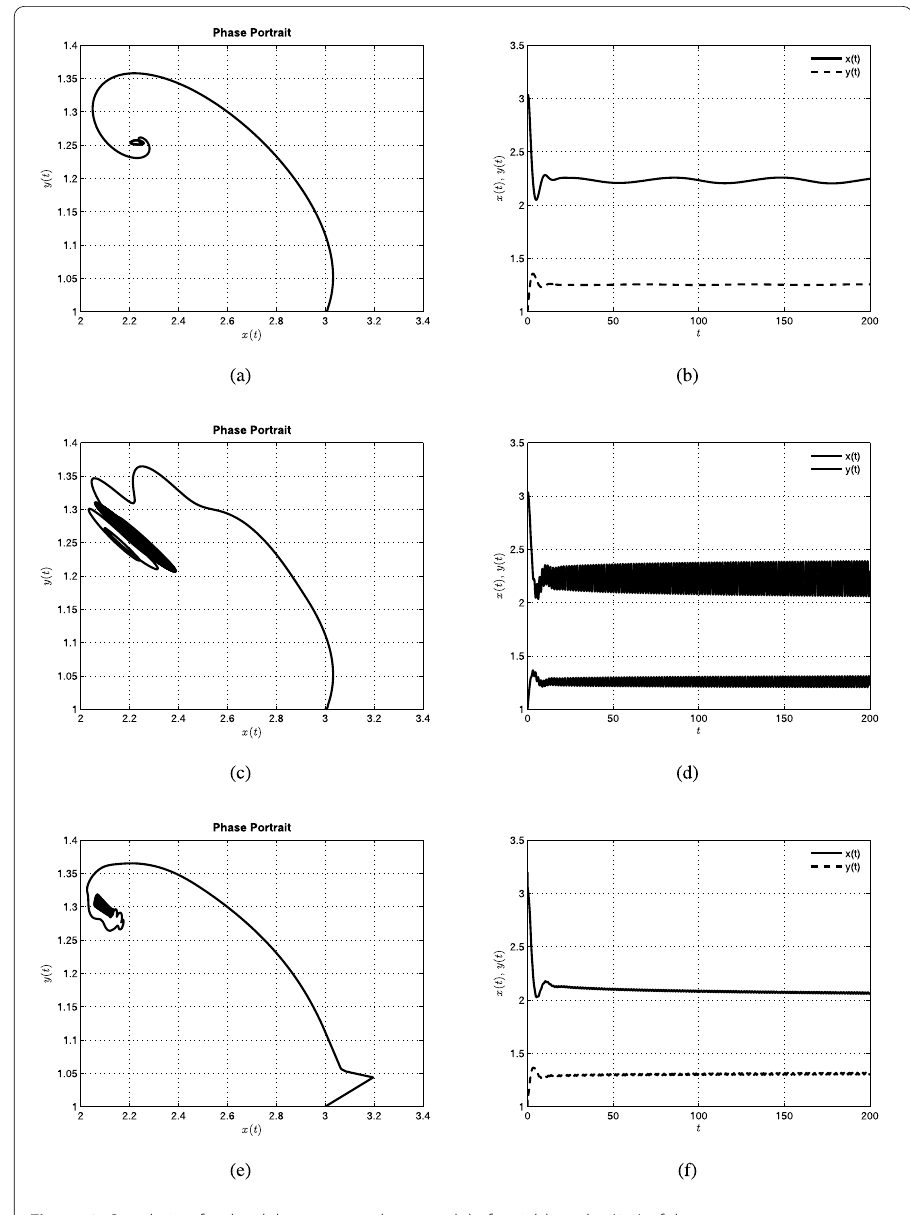
Figure 3 Simulation for the delay prey–predator model of variable order (2.8) of the Atangana–Baleanu–Caputo fractional derivative numerically mentioned as Eq. (4.5). In ( a )–( b ) phase portrait and time series x ( τ ) and y ( τ ) for (cid:2) = | sin( (cid:2)τ ) | , ς = tanh(3 – τ ), and κ = 0.01 seconds. In ( c )–( d ) phase portrait and time series x ( τ ) and y ( τ ) for (cid:2) = 1 – 1 and time series x ( τ ) and y ( τ ) for (cid:2) = | sin( (cid:2)τ ) | , ς = 1 – 1